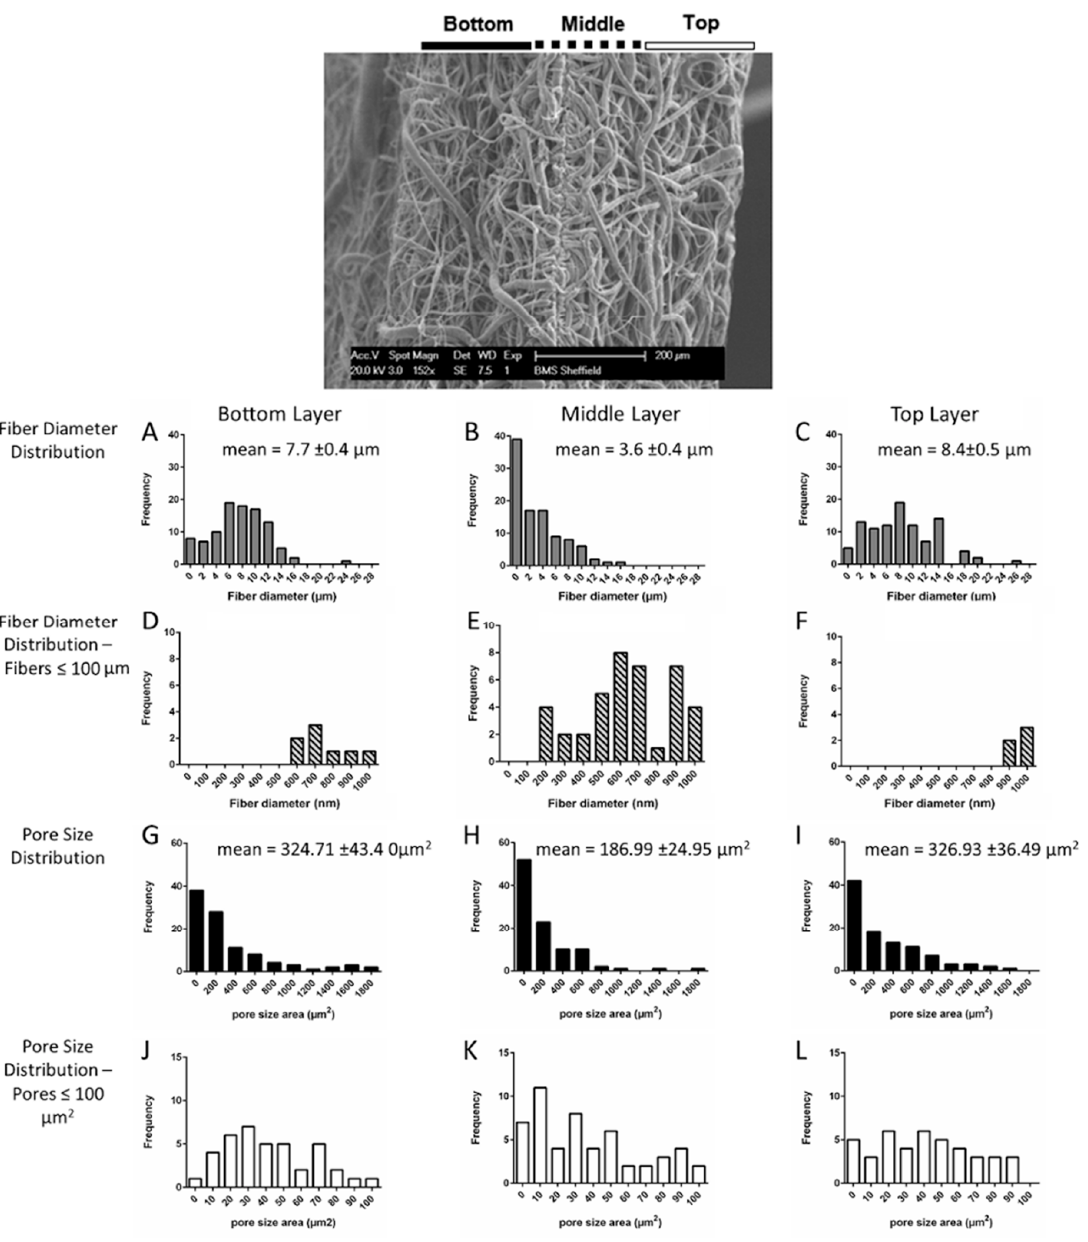
Figure 1. SEM image of the tri-layer electrospun PCL scaffold in side view (top), scale bar: 200 µm. Overall fiber diameter distribution ( A – C ) and the distribution specifically below 100 µm ( D – F ) in the bottom ( A , D ), middle ( B , E ), and top ( C , F ) layers; overall fiber pore size distribution ( G – I ) and the distribution specifically below 100 µm 2 ( J – L ) in the bottom ( G , J ), middle ( H , K ) and top ( I , L ) layers ( n = 100 from 4 SEM images per layer, mean ± SE).